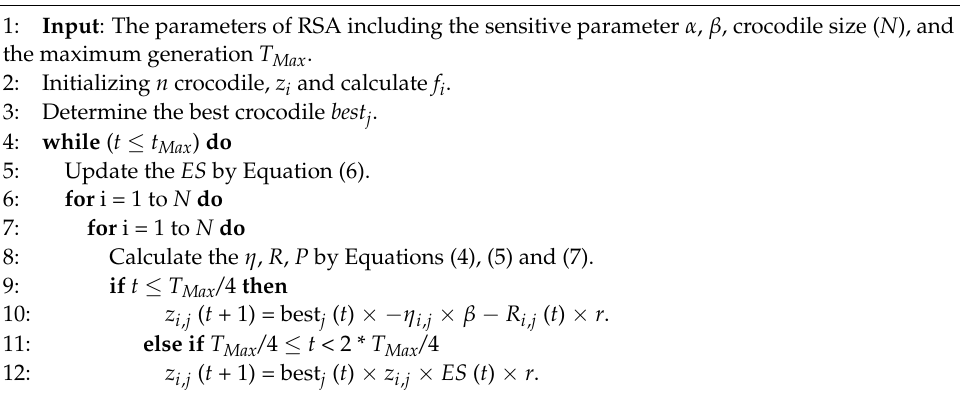
Algorithm 1: The framework of the